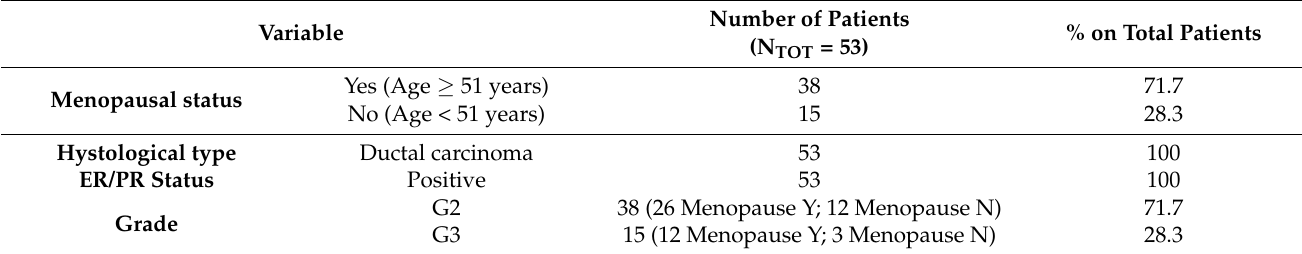
Table 1. Histopathological characteristics of tumors of patients who had undergone breast surgery.